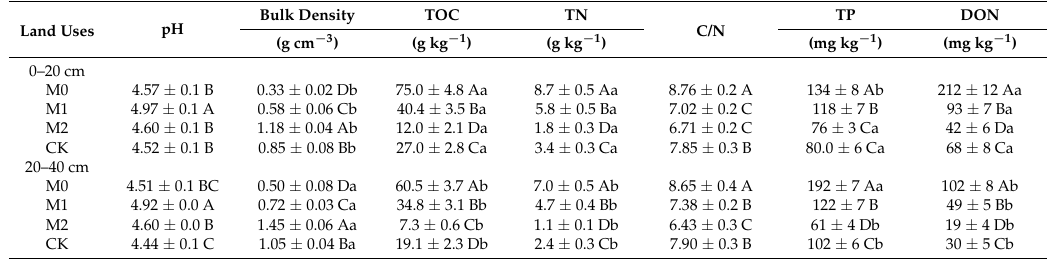
Table 1. Physiochemical properties of soils in the studied forests.